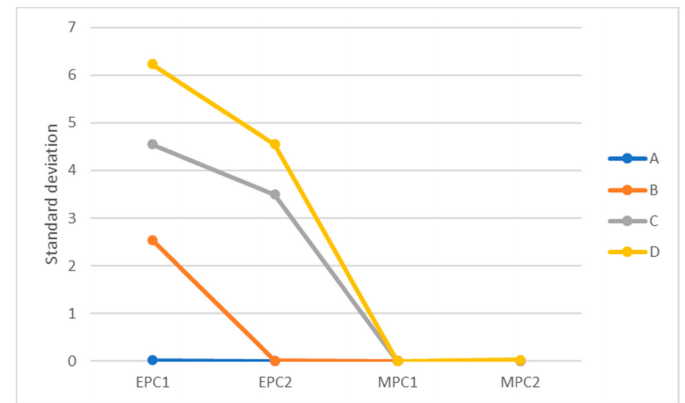
Figure 8. Standard deviation for different